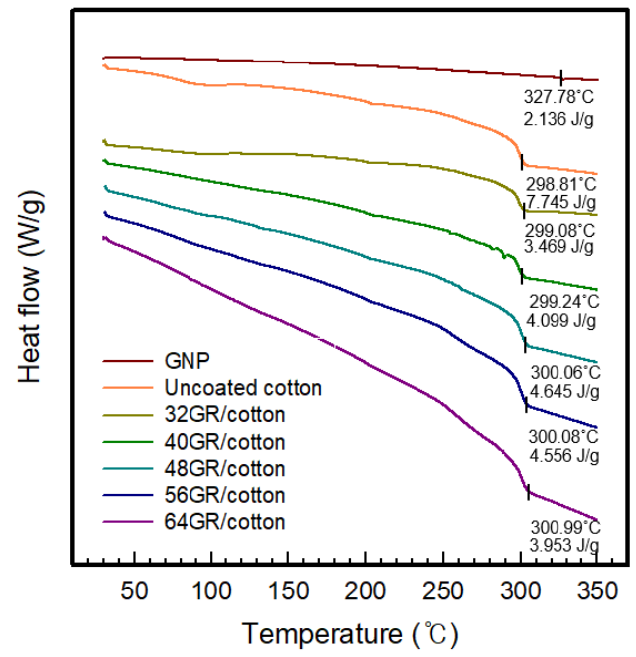
Figure 5. Di ff erential scanning calorimetry (DSC) curve of GR / cotton coated with various high-content Figure 5. Differential scanning calorimetry (DSC) curve of GR/cotton coated with various high- of graphene content of graphene nanoplatelets.